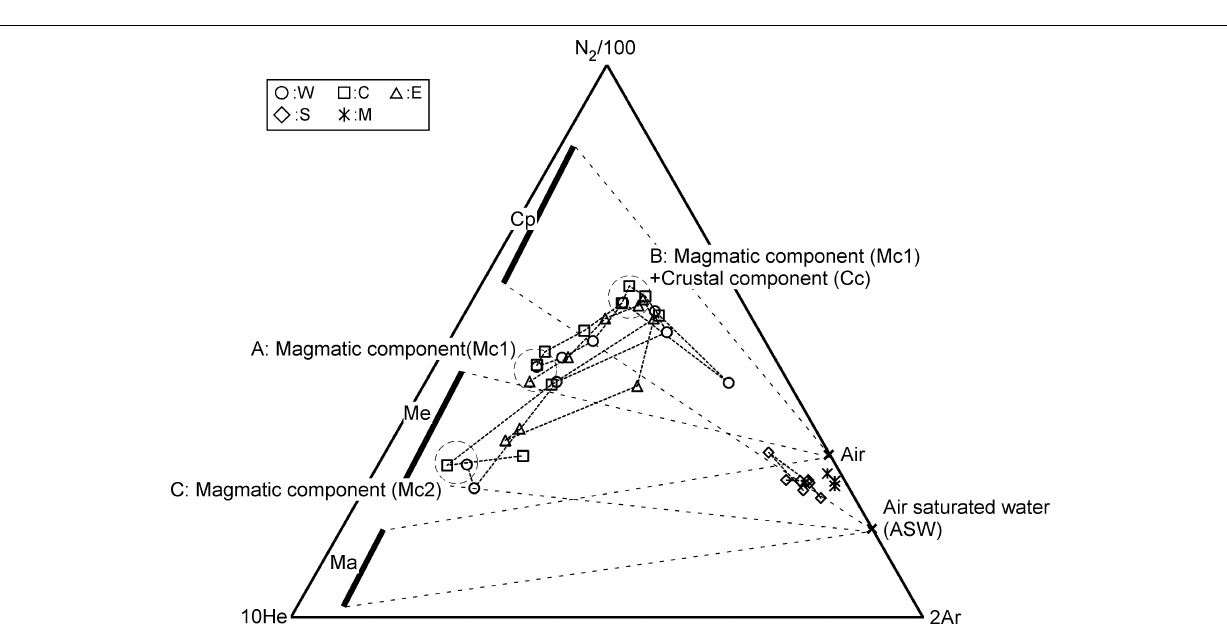
FIGURE 9 | He-N 2 -Ar ternary molar composition of fumarolic gas. The position of A, B, and C indicate the composition in July 2014, November 2017 and August 2018, respectively. Cp, Me, Ma represent the typical endmember composition of gas from volcanoes on circum-Pacific volcanic belt, Mediterranean sea and hot spots with mantle origin, respectively (Giggenbach,